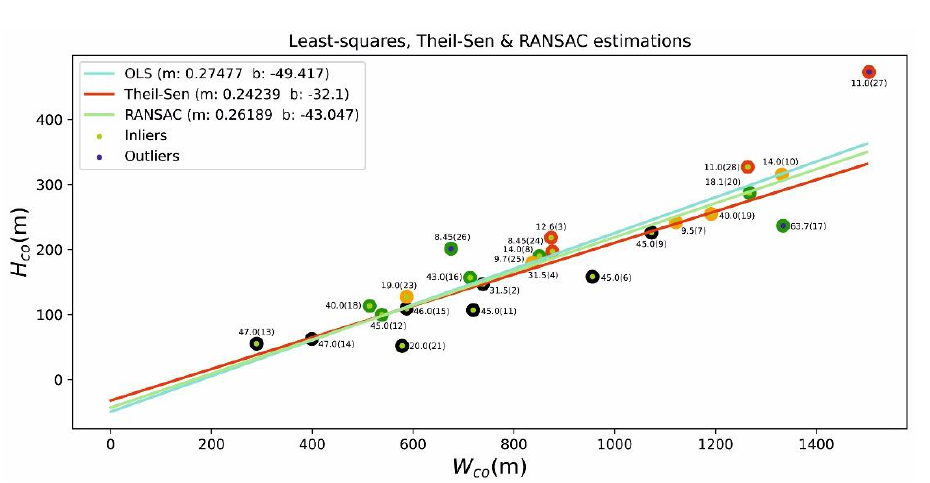
Figure 11. Modeling of W co – H co relationship using the ordinary least squares method (OLS), Theil – Sen estimation and the RANSAC algorithm. The values indicated are the ages of the cones, and the IDs (see Table 1) are indicated in brackets. The color code is the same as for Figures 5, 7 and 10.